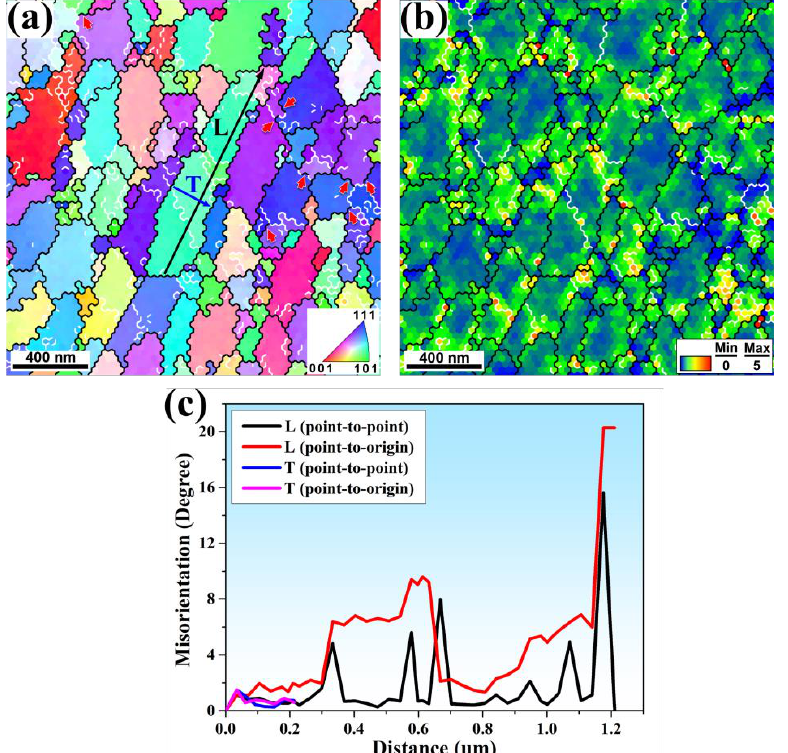
Figure 6. Detailed EBSD micrographs of elongated large grain inside the shear band (step size: 35 nm): ( a ) a typical IPF orientation map in the shear band superimposed by LAGBs and HAGBs; ( b ) KAM map superimposed by LAGBs and HAGBs; ( c ) the point-to-point and point-to-original misorientation profile along the path “L” and “T” drawn in an elongated grain in ( a ).